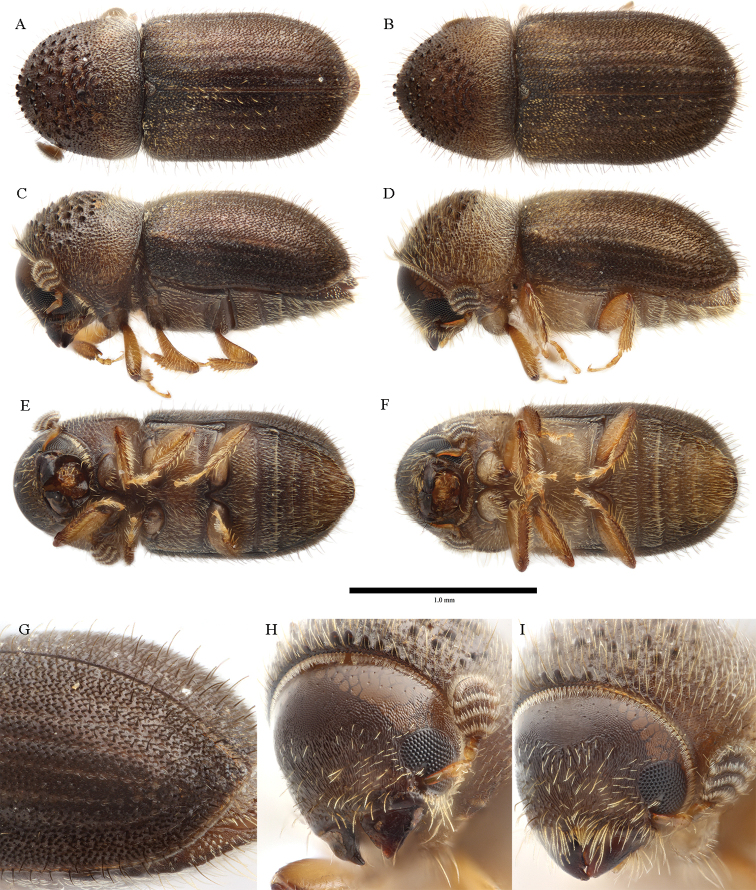
Cryphalus
paramangiferaeA, C, E, G, H holotype, female, UFFE:34967 B, D, F, I paratype, male, UFFE:34969.